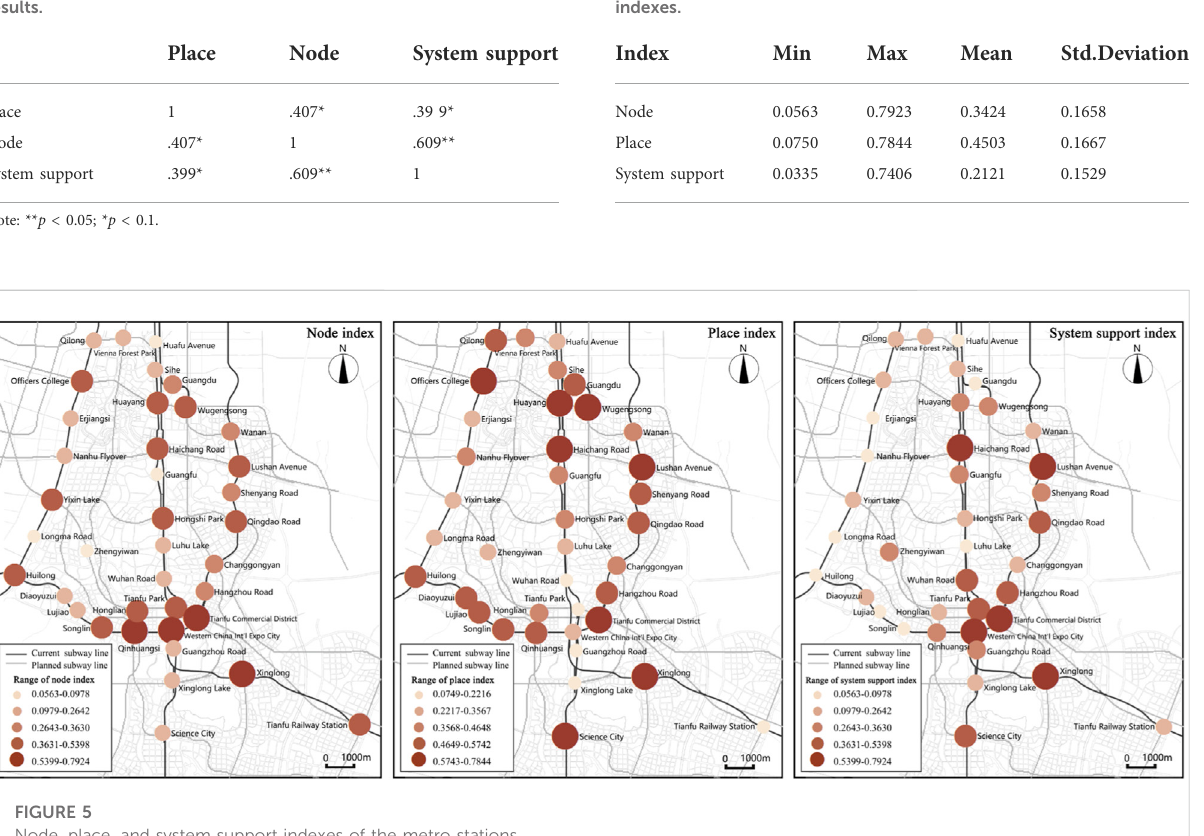
TABLE 5 Correlation between the node, place, and system support results.